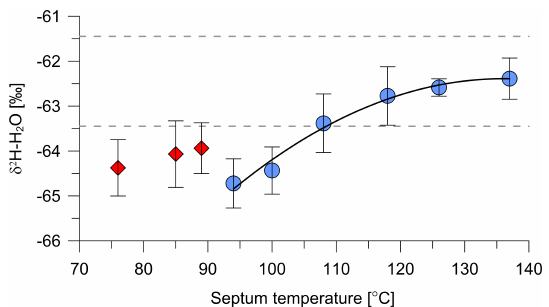
Figure A1. The δ 2 H variation of H 2 O injections with septum tem- peratures. Blue circles show average δ 2 H–H 2 O values for septum temperatures above 90 ◦ C, the black line is the quadratic polynomial fit to the data above 90 ◦ C while red diamonds display δ 2 H–H 2 O values at septum temperatures below 90 ◦ C. The error bars show 1 σ standard deviations and the grey-dashed lines indicate the typical precision limit of 1‰ for δ 2 H–H 2 O analysis (Gehre et al., 2004) around the δ 2 H–H 2 O value of the polynomial fit for the septum temperature of 130 ◦ C (set point during calibration experiments). The grey dashed lines show that our δ 2 H–H 2 O analyses remain within a typical precision level as long as the septum temperature is controlled to ∼ 130 ± 10 ◦ C.